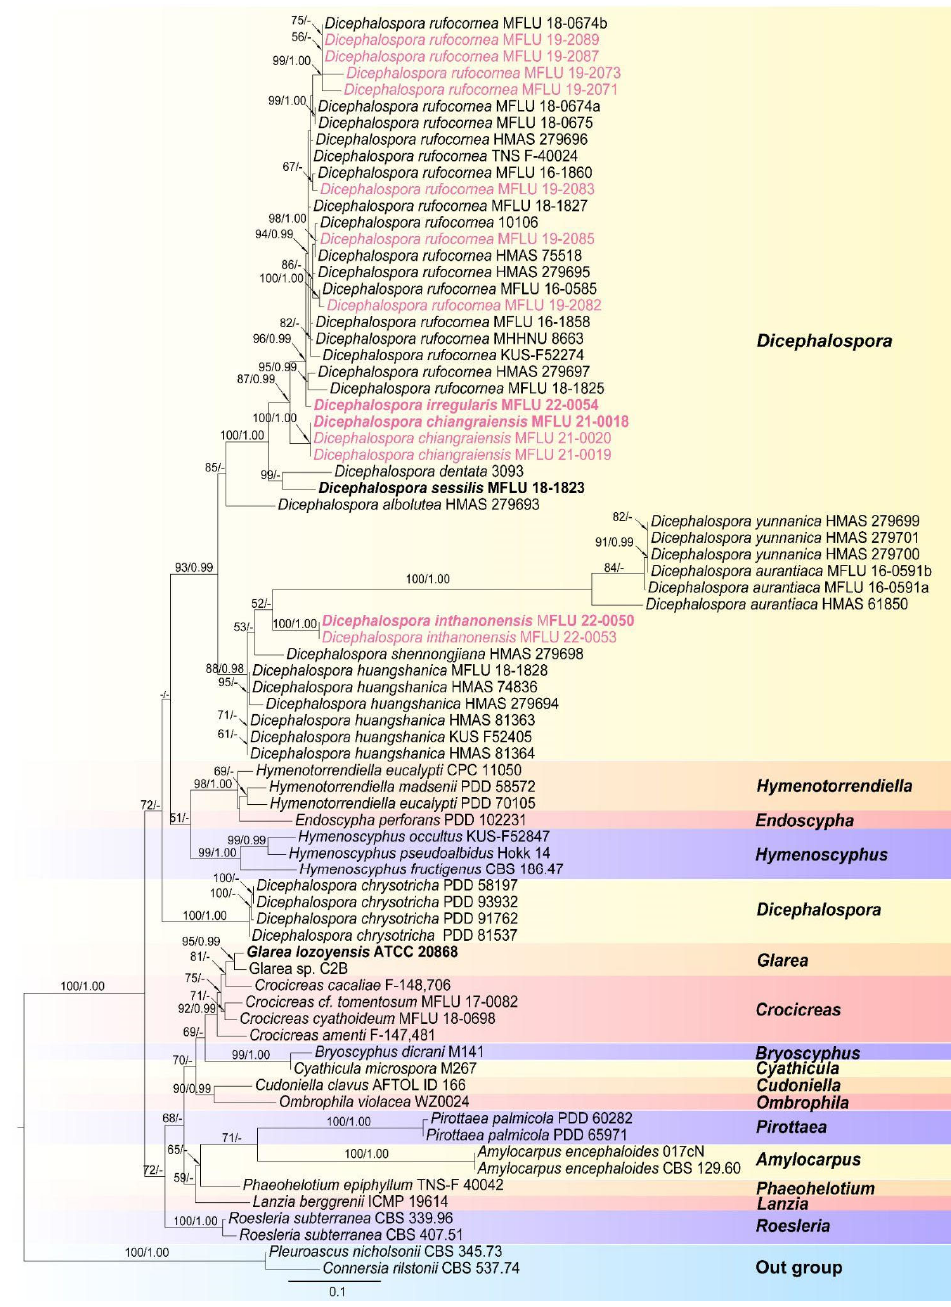
Figure 2. Phylogram of RAxML analysis based on ITS sequence dataset. Bootstrap support values for maximum likelihood equal to or greater than 50%, and Bayesian posterior probabilities equal to or greater than 0.95 BYPP are indicated at the nodes as ML/ BYPP. The tree is rooted to Connersia rilstonii (CBS 537.74) and Pleuroascus nicholsonii (CBS 345.73). Ex ‐ type strains are in bold . The newly generated sequences are in red font. In the phylogenetic analyses, our novel taxa ( D. chiangraiensis , D. irregularis , and D. inthanonensis ) clustered separately from other known taxa. To further confirm their evo ‐